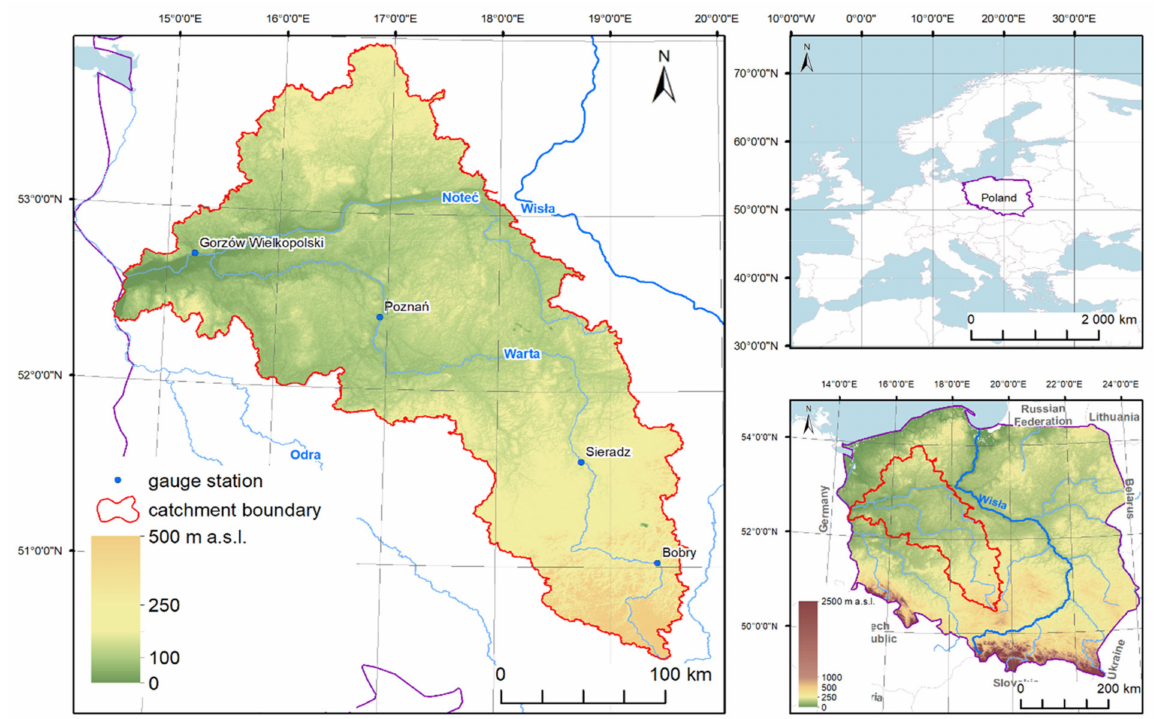
Figure 1. Map of the Warta River basin with the locations of hydrometric stations. Due to the large latitudinal and longitudinal extent of the Warta River catchment area, regional differences in climatic conditions are visible within its range. The area belongs to nine climatic regions [57]. The average annual temperature in the river basin ranges from 7.5 ◦ C in the north to 8.5 ◦ C in the west. Annual precipitation totals range from 520 mm in the northeast to 675 mm in the